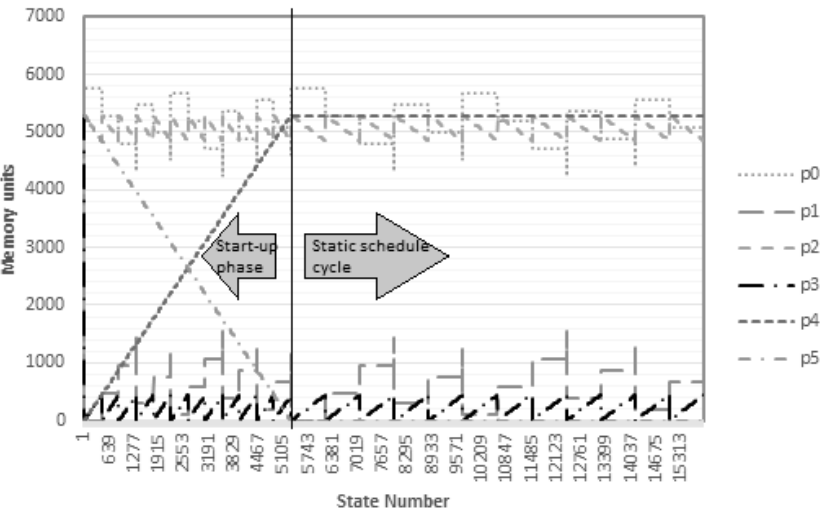
Figure 6. Places’/buffers’ storage resource